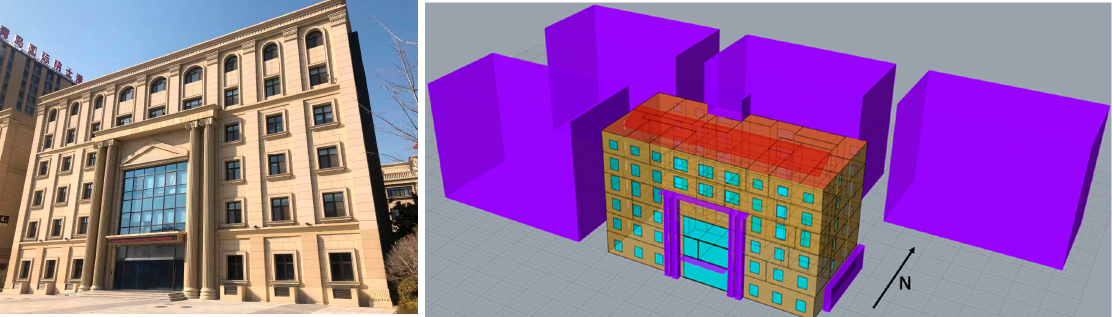
Figure 2. A real office building model in Qingdao, China.